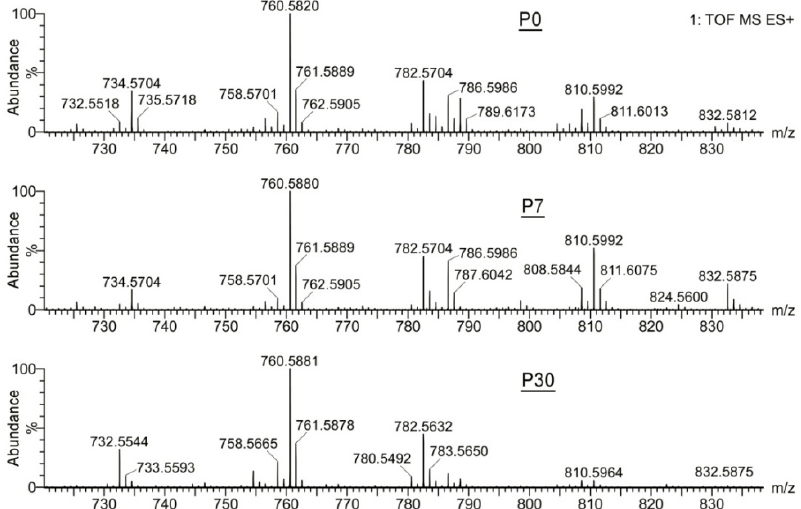
Figure 3. Observation ESI MS PIM mass spectra of samples shown in Figure 2. The sphingomyelin and phospholipid species observed in P0, P7, and P30 samples varied somewhat with the age of the mice, but their intra-group differences were of the same magnitude as the P0 to P30 inter-group differences, and concerned only a few species, such as a phosphatidylcholine with m/z values of 810.5992 and 832.5875 (a proton and sodium adducts), and its homologue with m/z 786.5986 and 808.5844 (same adducts). Thus, the differences between the samples may be related to the fact that these ubiquitous phospholipids, being present in all tissues, could originate from the connective tissue that surrounds Meibomian glands and tarsal plates and whose remnants could inadvertently contaminate the samples while dissecting the tissues.